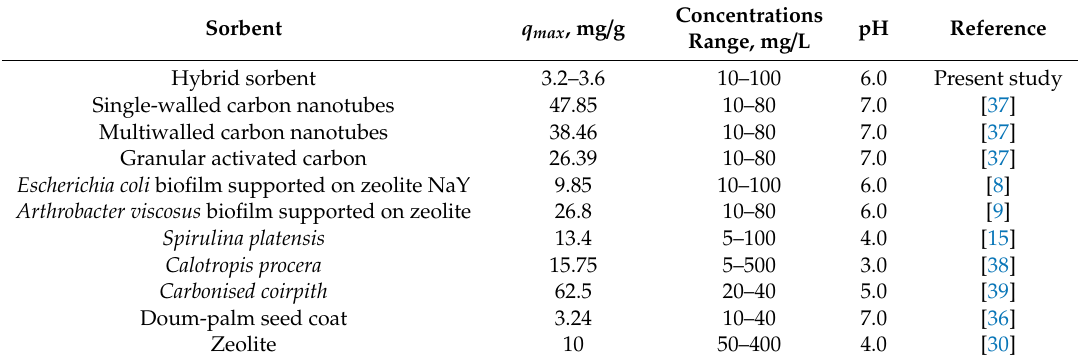
Table 7. Comparison of the sorption capacity toward Ni(II) of studied hybrid, as well as other